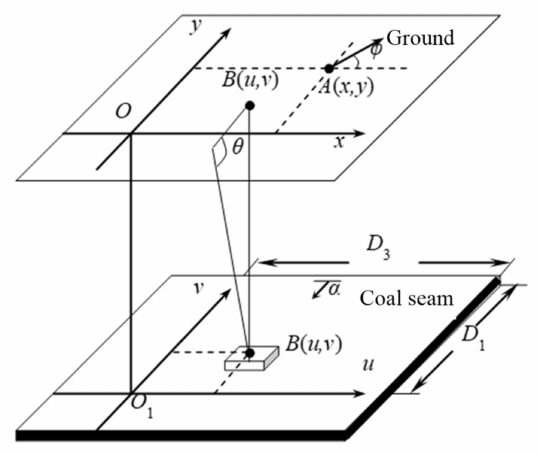
Figure 12. Space mining coordinate